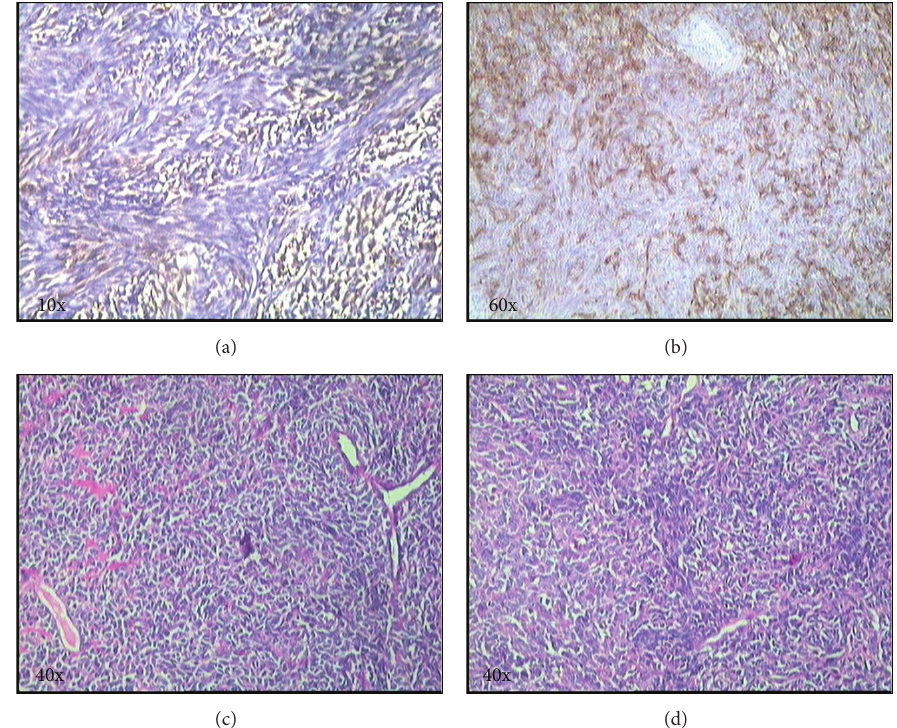
Figure 2: Immunohistochemistry and histopathological sections reveal tumor cells positive for bc12 (a) and focally positive for EMA (b), and the tissue shows polygonal to spindle shaped cells arranged in whorls and storiform pattern ((c), (d)) on haematoxylin and eosin